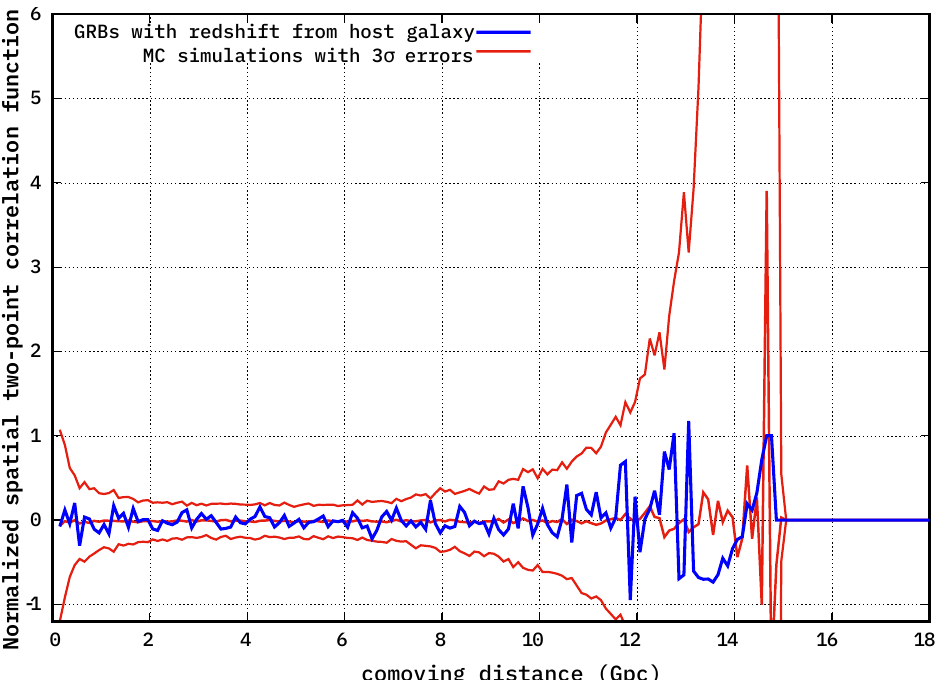
Figure 11. The Spatial Two-Point Correlation Function of the host galaxy based redshift fraction (blue) with the corresponding MC simulations’ mean and ± 3 σ errors (red